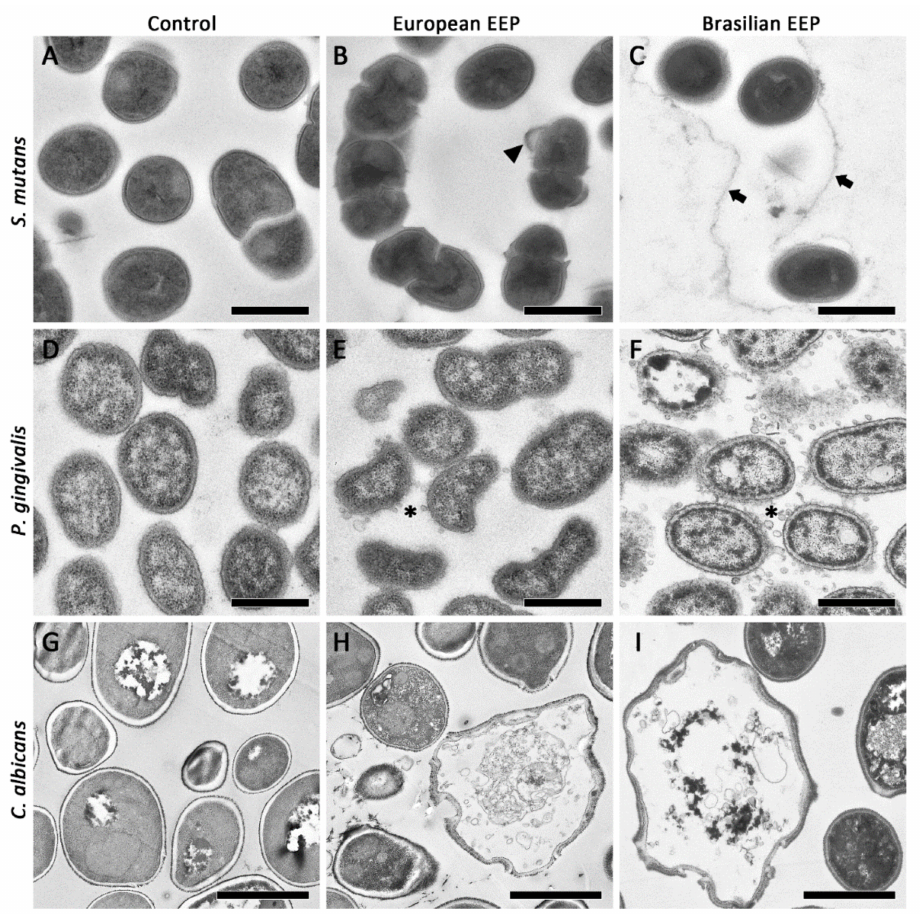
Figure 2. Transmission electron microscopy images of Streptococcus mutans ( A – C ), Porphyromonas gingivalis ( D – F ), and Candida albicans ( G – I ) without ( A , D , G ) and with 5 min exposure to 25 mg/mL propolis of the different ethanolic propolis extracts (European: ( B , E , H ); Brazilian green: ( C , F , I )). Bar ( A – I ) 500 nm for bacteria, 2 µ m for C. albicans ; After exposure to propolis there are attachments visible (arrowhead), an enclosing compartment—maybe made of EPS (arrows), and a lot of small (40 nm) vesicles